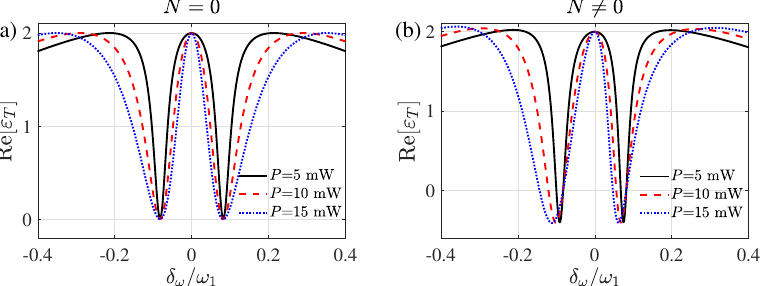
Figure 4. The absorption property Re[ ε T ] as a function of the normalized frequency δ ω / ω 1 for different powers P of the driving field in the case of ( a ) N = 0 and ( b ) N (cid:54) = 0. The other parameters are the same as given in Figure 2.